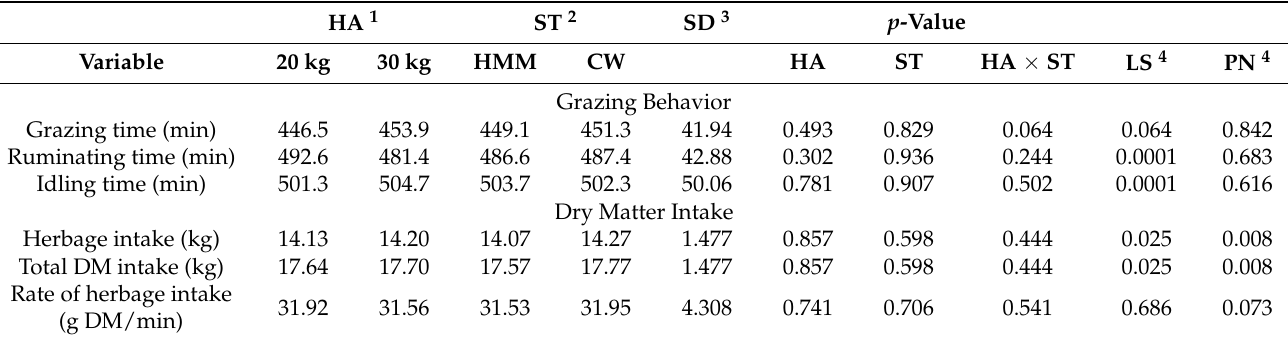
Table 2. Effect of herbage allowance and supplement type on grazing behavior and dry matter intake of lactating dairy cows ( n =